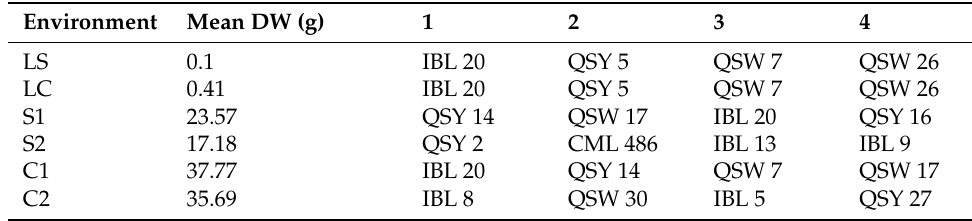
Table 4. Best four genotypes in each of the six